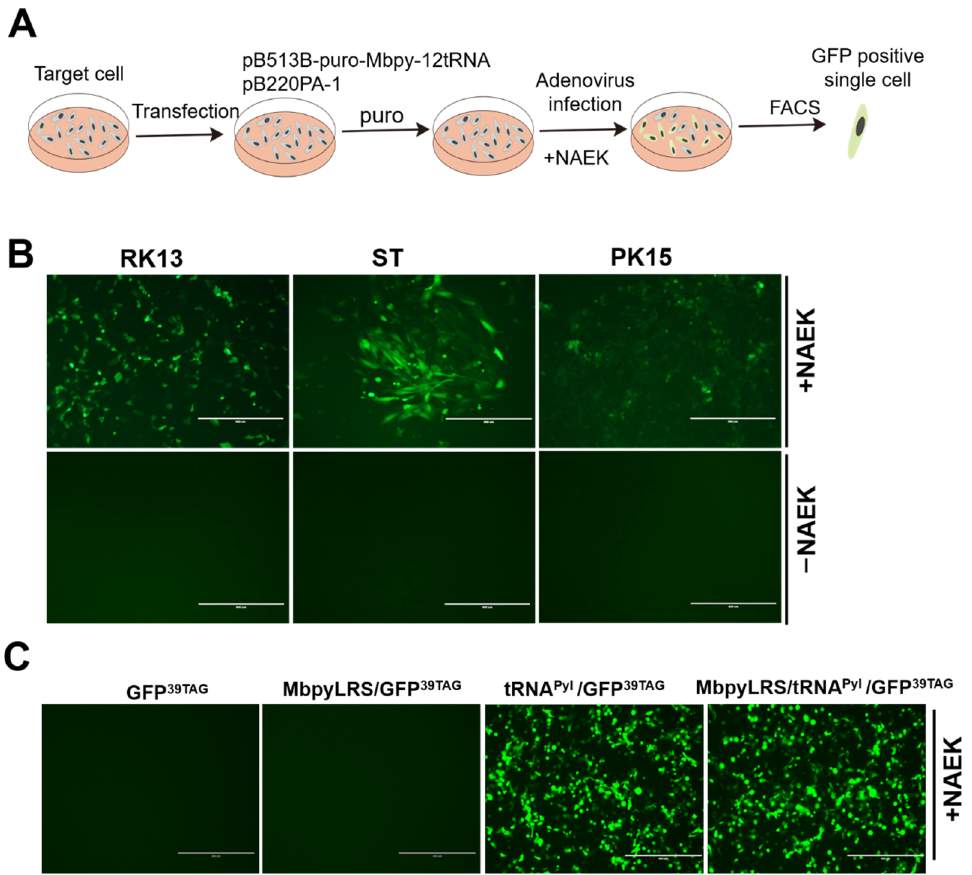
Figure 5. Generation of transgenic cell line containing MbpylRS/tRNA Pyl orthogonal system. ( A ) Schematic representative of the process for generation of transgenic cells containing MbpylRS/tRNA Pyl orthogonal system. ( B ) The well-growth transgenic RK13, ST, PK15 cell lines were infected with packaged adenovirus in the presence of UAA or not. The GFP 39TAG expression in these cells was observed by fluorescence microscopy. Scale bars, 400 µm. ( C ) Detection of the key limit factor for orthogonal system fail to translation in RK13 transgenic cell line by transfecting of MbpylRS, GFP 39TAG or tRNA Pyl individually or together. The GFP 39TAG expression in these groups was observed by fluorescence microscopy. Scale bars, 400